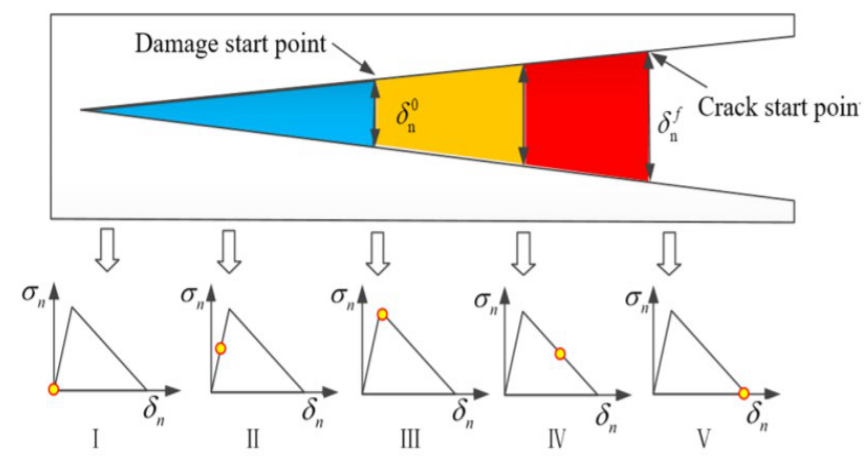
Figure 52. Cohesive elements failure process [255].